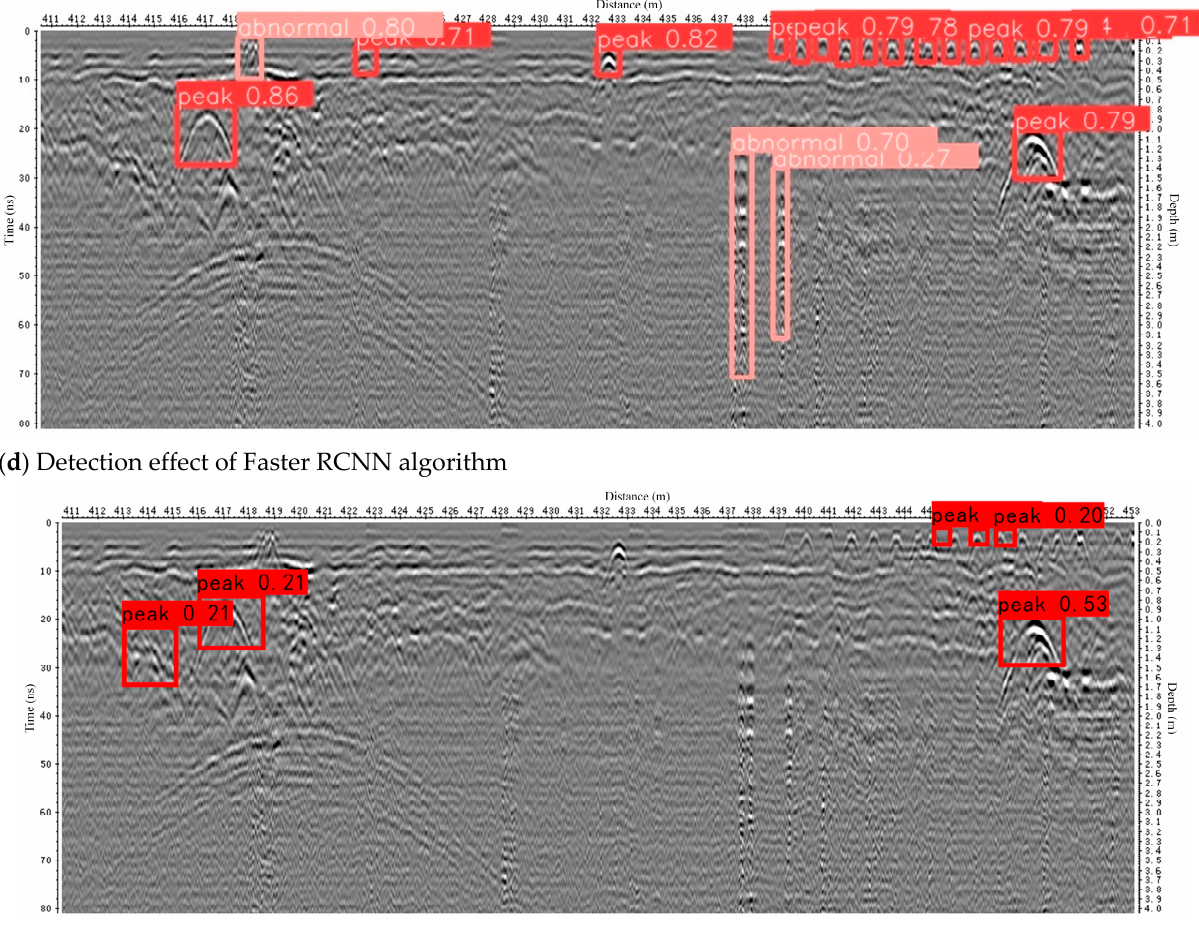
Figure 4. Comparison of the effect of YOLOv5 algorithm and other two target detection algorithms in actual detection.